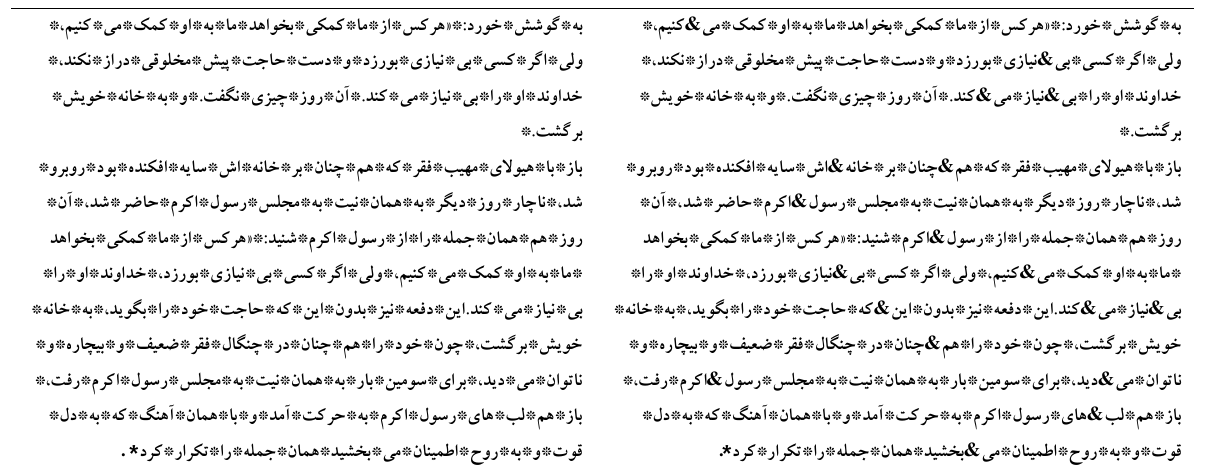
Table 1. a sample of created parallel corpus. The left side is unedited corpus and the right side is edited corpus. unedited